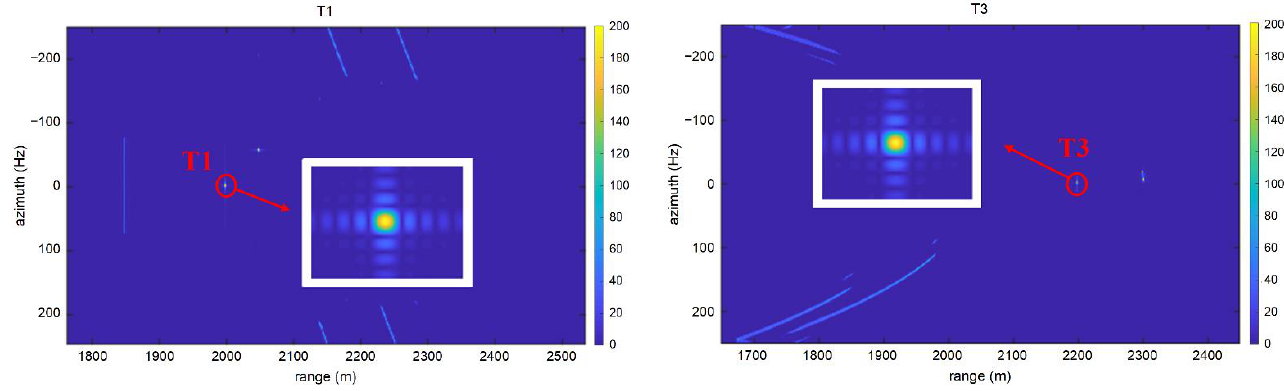
Figure 7. Refocused result of the moving targets T1 and T3.